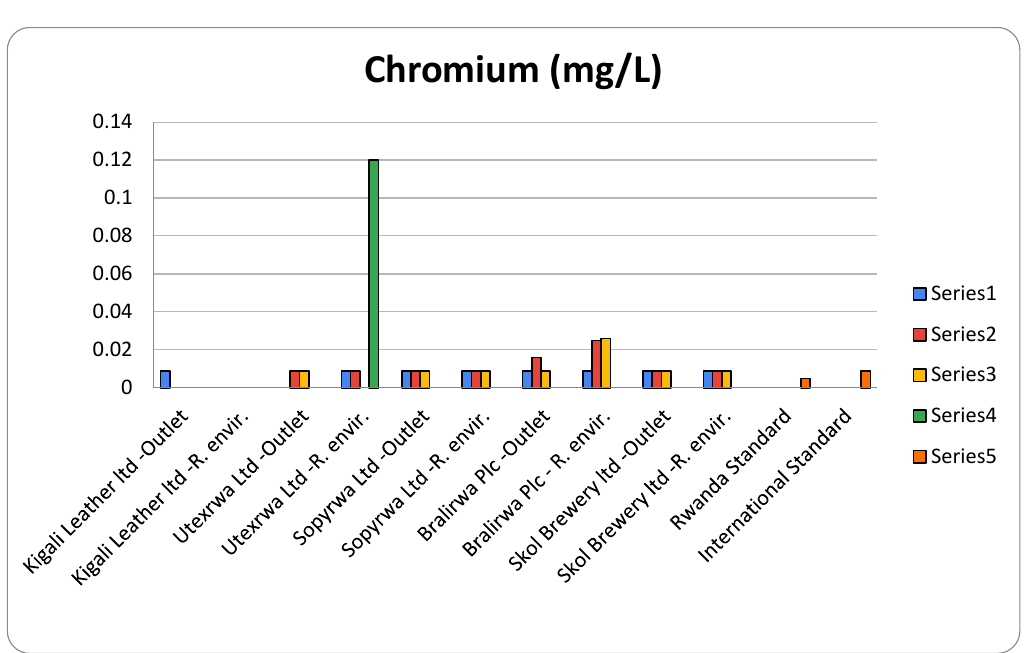
Figure 8. Cadmium discharge levels per site .